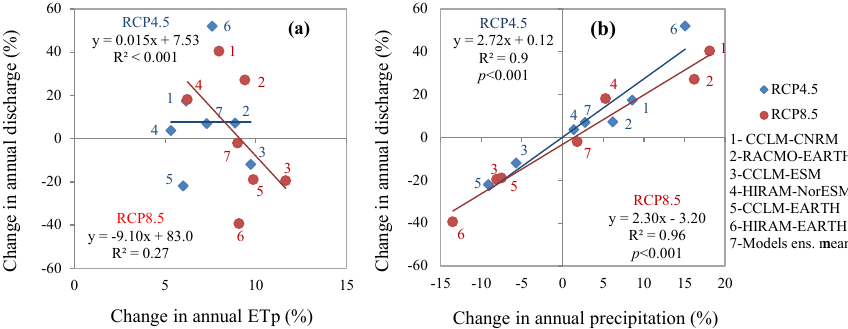
Figure 10. Change in the annual discharge as a response to potential evapotranspiration (a) and precipitation (b) change under emission scenarios RCP4.5 and RCP8.5. Projected precipitation, potential evapotranspiration, and discharge changes are calculated comparing